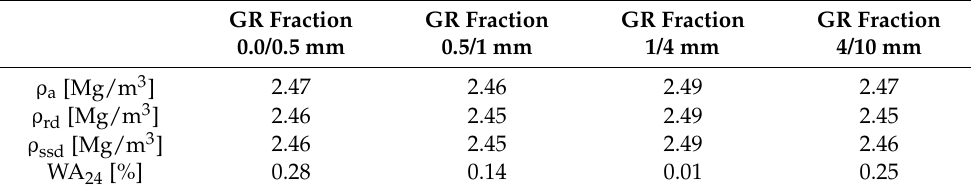
Table 5. Determination of absorptive capacity and density of grains of individual recycled glass fractions.